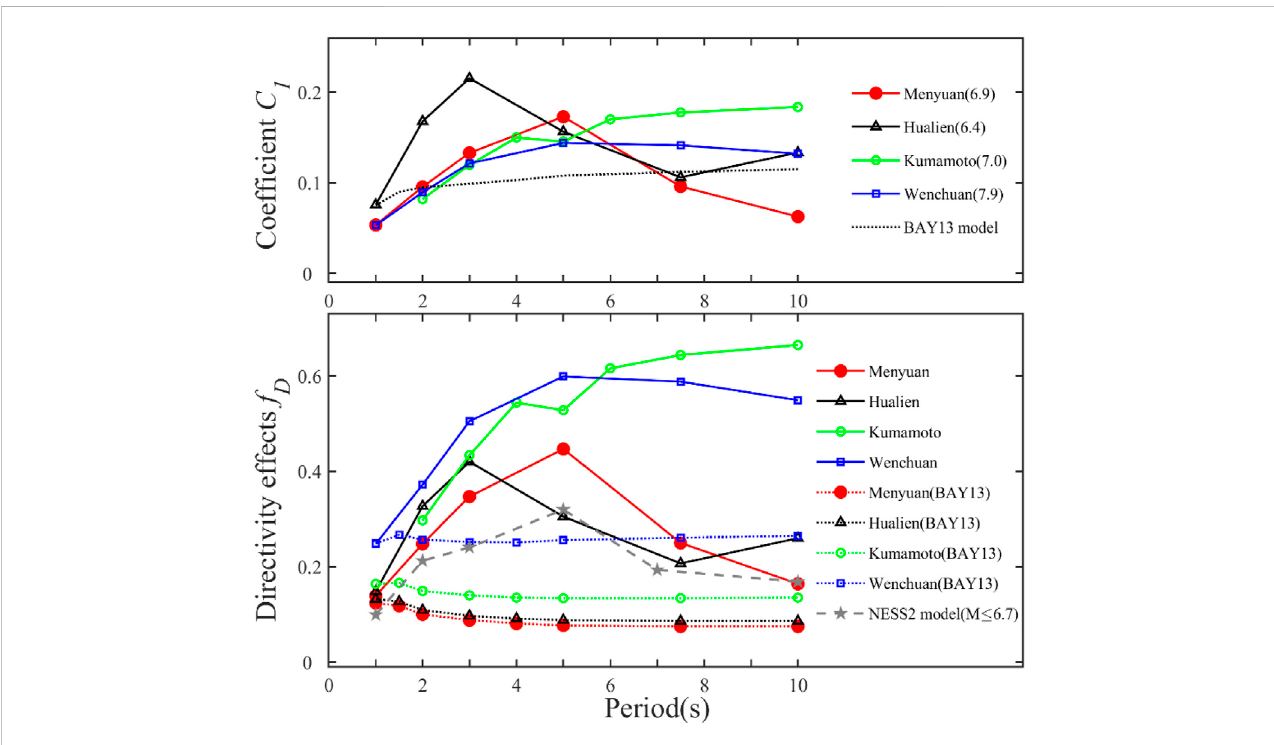
FIGURE 10 Comparison of near- fi eld directivity effects during the Ms 6.9 (Mw 6.6) Menyuan earthquake with the Mw 6.4 Hualien earthquake, Mw 7.0 Kumamoto earthquake,Mw7.9Wenchuanearthquake,and theBAY13model. TheNESS2 modeldenotesthepredictionoftheadjustedground motion modeldeveloped by Sgobba et al. (2021).